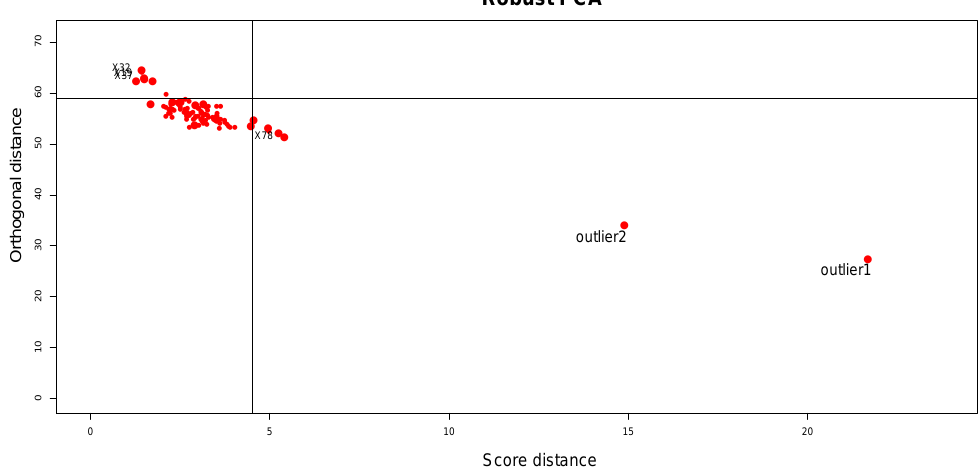
Figure 6. DD-plot of the first simulated dataset. We reproduce a bimodal trend of the sampling distributions by setting 100 rows in X n , m to a normal distribution N ( 3, 0.5 ) . As for the four outliers, two of them retain the normal distribution, with different mean and variance (1 and 1.1 for the means and 1 and 0.9 for the values of the second pulse); while the remaining two are generated without central t -students with 2 and 2.1 degrees of freedom and 2 and 2.2 without central parameter,